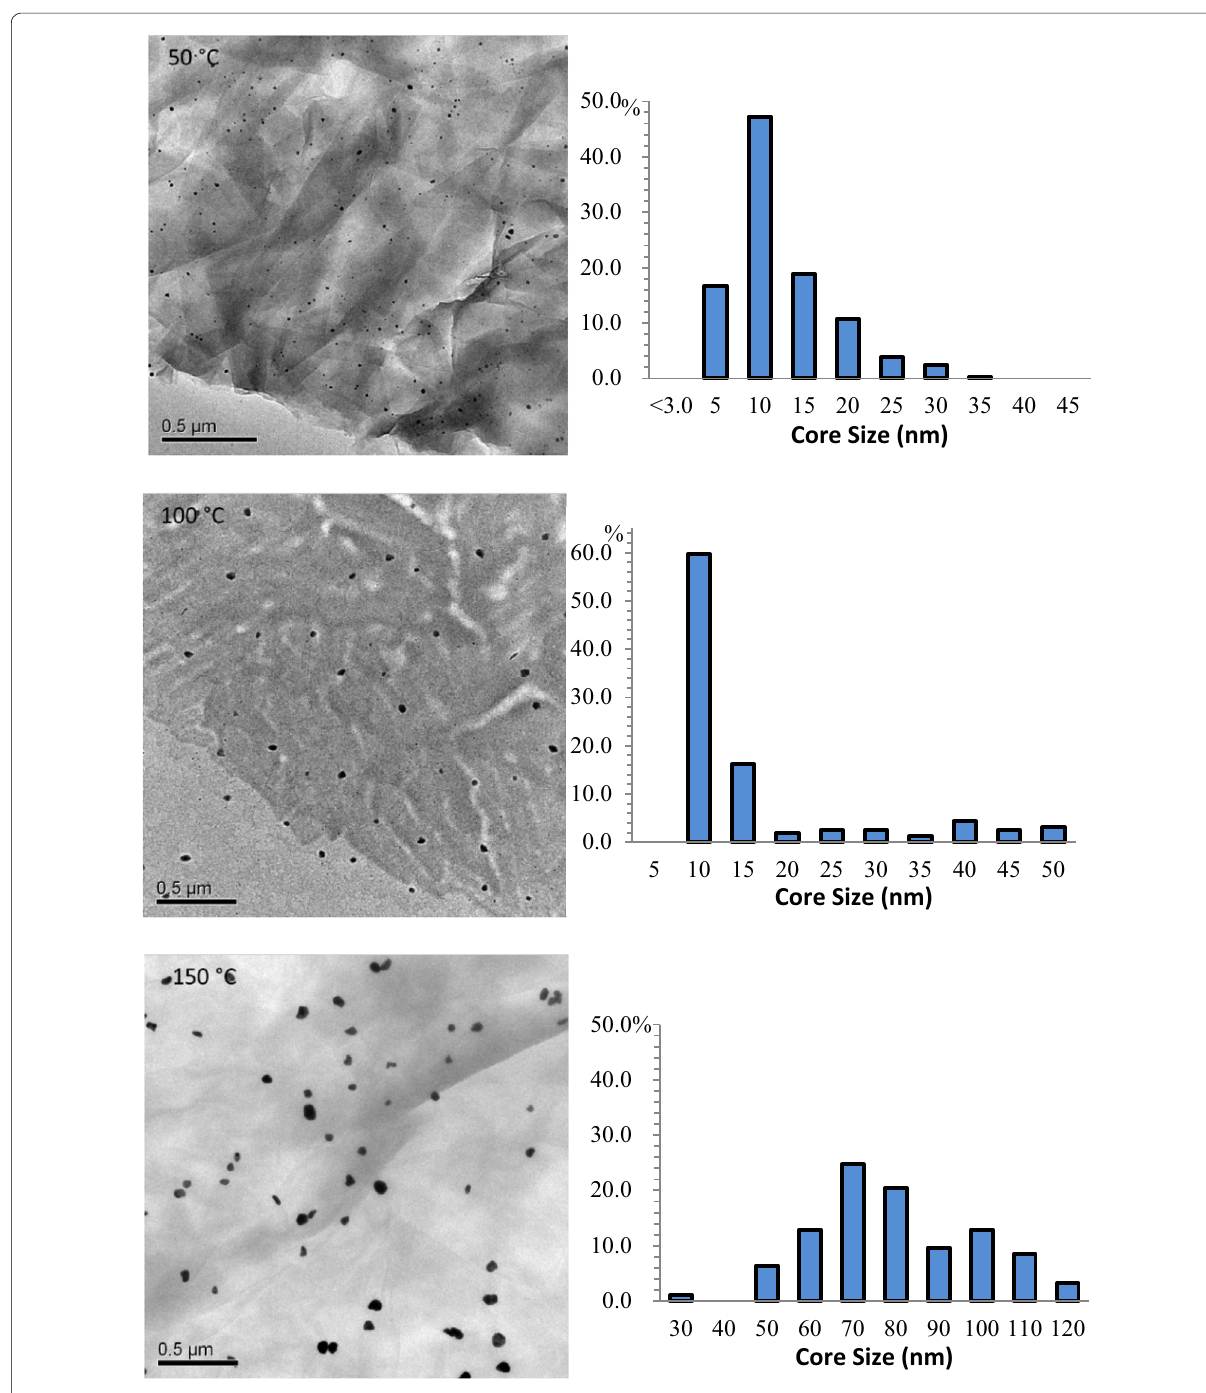
Fig. 7 TEM images and histograms of cAuNP 3nm ‑GO heated at 50, 100, and 150